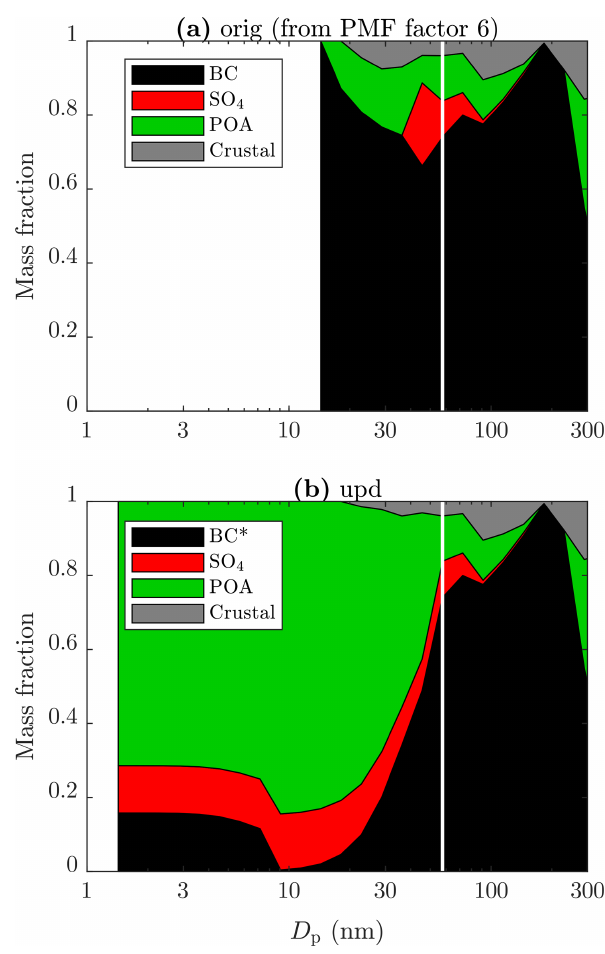
Figure 2. Particle chemical composition (a) of the PMF factor 6 and (b) after updating the emission inventory. The composition of the emitted particles larger than 57nm (vertical lines) remains un- changed, and particles larger than 300nm are not shown due to their